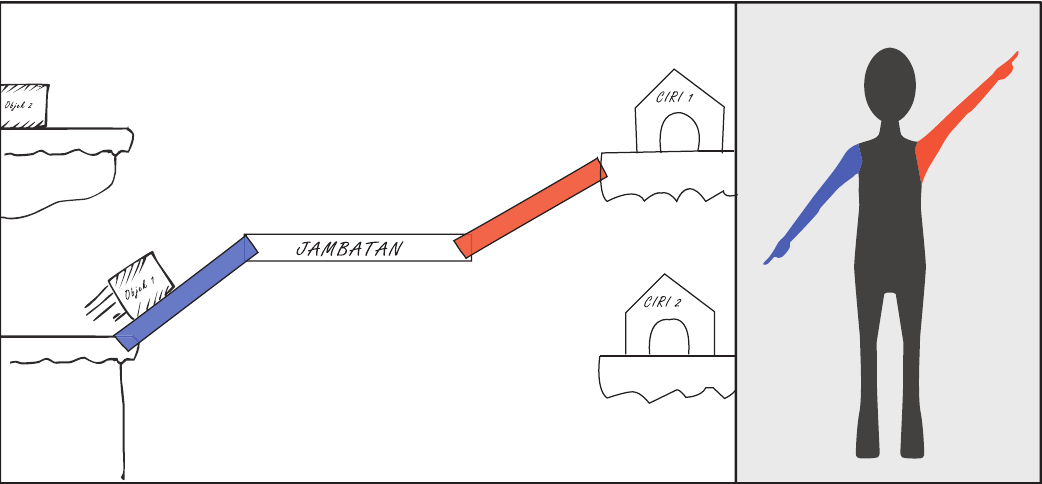
Figure 8: The game sketches.